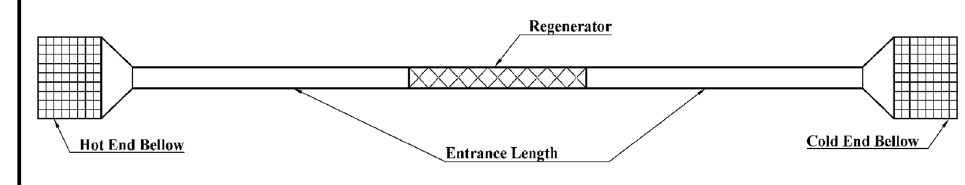
Figure 6. 2D Computational domain of the problem.